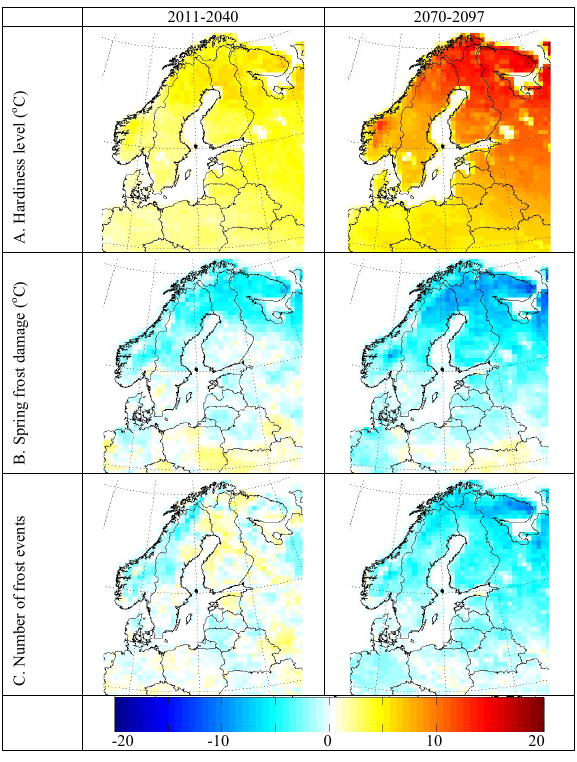
Figure 9. The cold hardiness level, number of spring frost events, and the maximum frost damage, calculated using temperature data from RCA3 driven at the boundary conditions with output from an ensemble of seven GCM data sets as input to the cold hardiness model. The change of the RCA3_GCM ensemble members in the most severe events ( i.e. 10% of the most harmful events), calculated for the time slices of 2011-2040 and 2070- 2097 in comparison with 1961-1990.